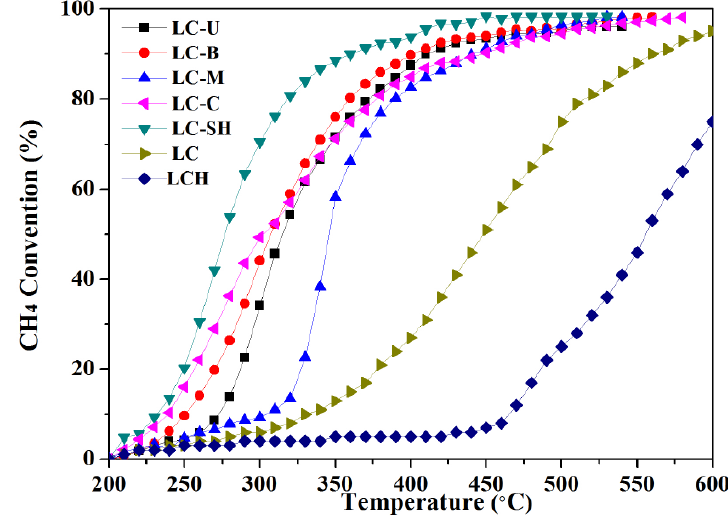
Figure 1. Effects of different nitrogen sources on catalytic activity of catalysts.